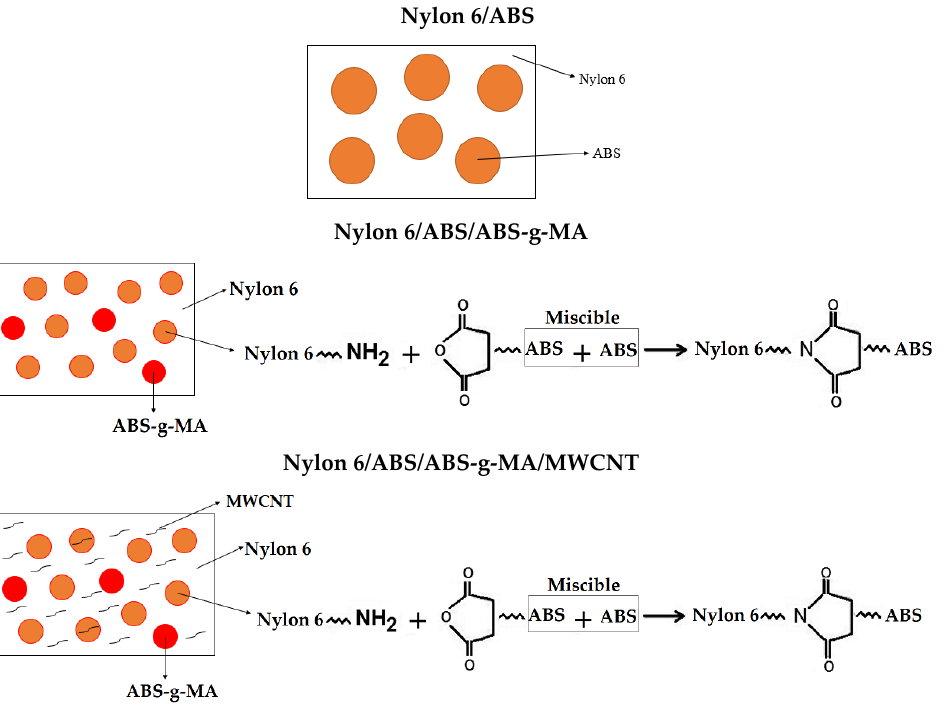
Figure 9. Schematic representation of the blends and nanocomposites.